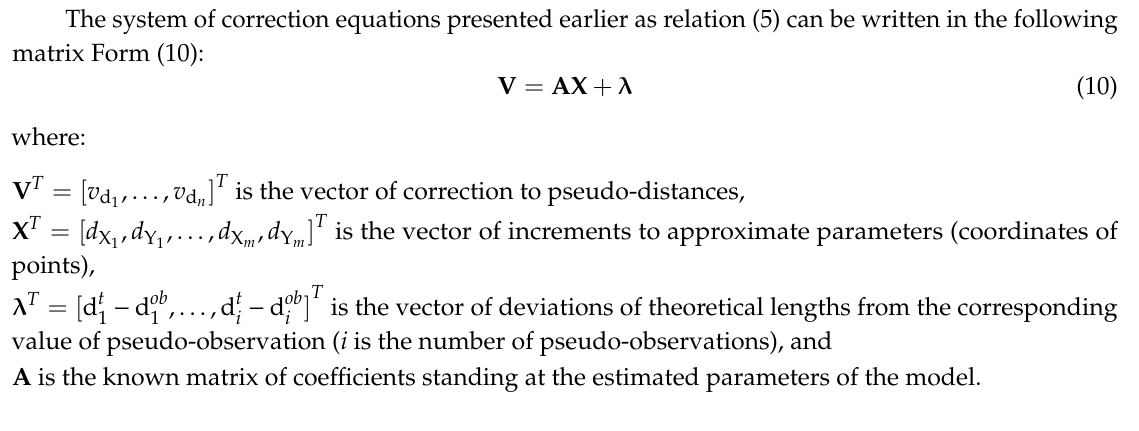
Table 3. Coordinates of controlled points in the external coordinate system.